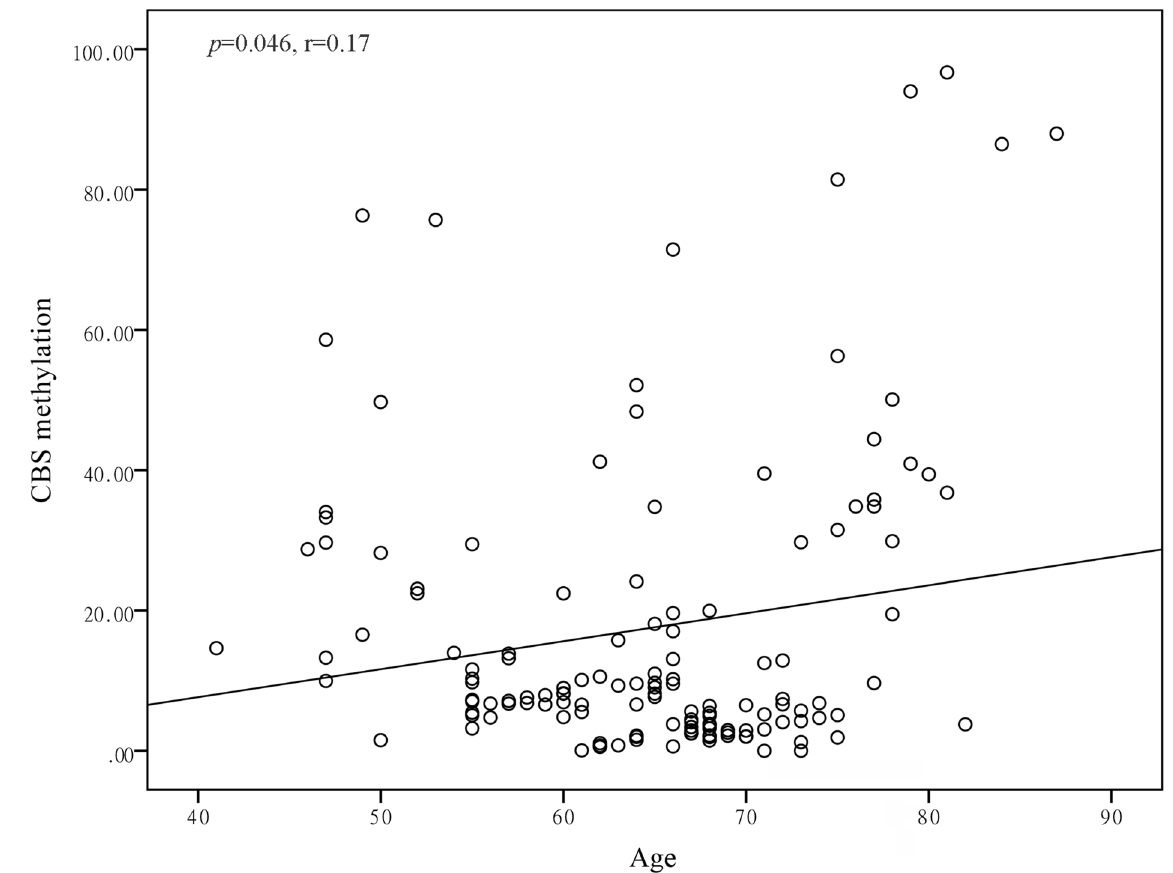
Figure 3 - Pearson correlation between age and CBS methylation in male healthy